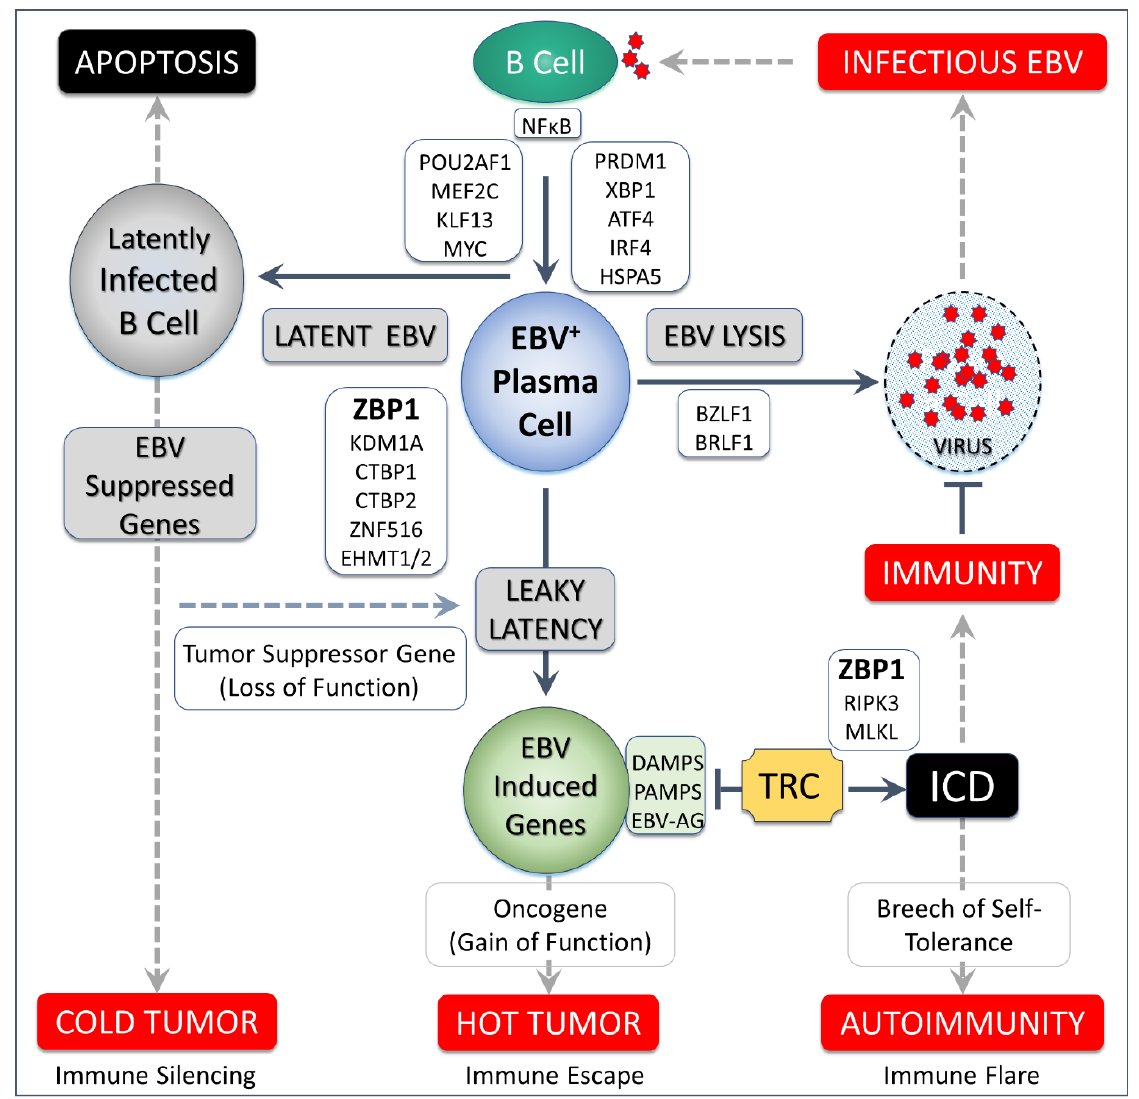
Figure 7. Epstein–Barr virus persists as a latent infection in B cells. Plasma cell formation can trigger the lytic program with three possible outcomes. The lytic program may complete and produce virus that spreads the infection. Latency may be maintained. Alternatively, suppression of EBV genes may be leaky with variable and partial suppression of viral genes, producing DAMPs (damage associated molecular recognition patterns), PAMPs (pathogen associated molecular recognition patterns) and EBV antigens (EBV-AG) to activate tissue resident cells (TRC) that act as an early warning system and induce inflammatory cell death (ICD). While TRCs may induce immunity, over time autoimmunity may develop. TRCs may also serve as inflammatory drivers of tumorigenesis. White boxes show host encoded transcription factors expressed in plasma cells, some of which regulate activation of EBV lysis [72]. ZBP1 is reported to bind components of the CTBP transcriptional corepressor complex [74] and may target it to Z-DNA formed in EBV promoter regions to maintain latency. EBV induced suppression of tumor suppressor genes and activation of oncogenes, including those encoded by the virus underlie the ~1-1.5% of cancers caused worldwide by the virus.